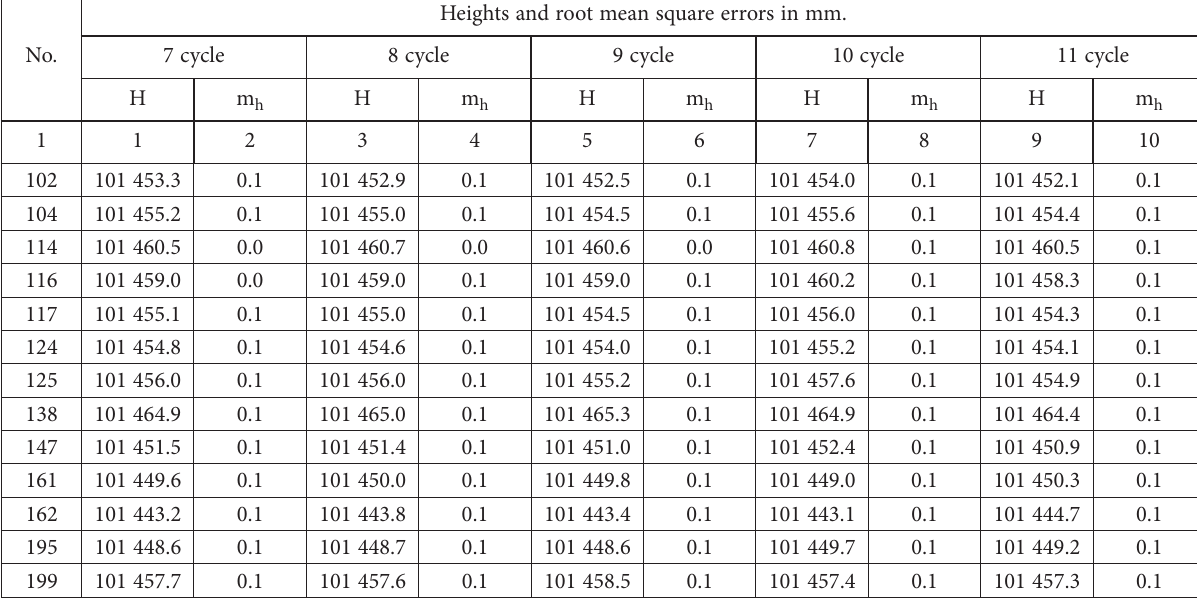
Table 2. Heights of sedimentary marks, laid on the first floor of the “Shuvar” mall, and their standard squares errors (7–11 cycles) Heights and root mean square errors in mm. No. 7 cycle 8 cycle 9 cycle